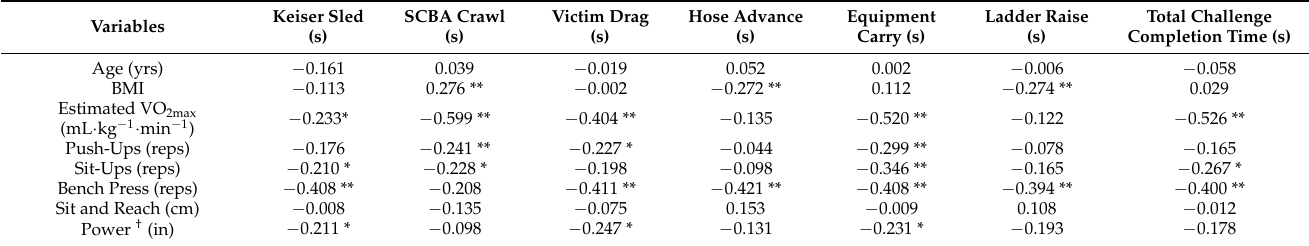
Table 6. Correlations between Fitness and Firefighting Ability at Week 7.